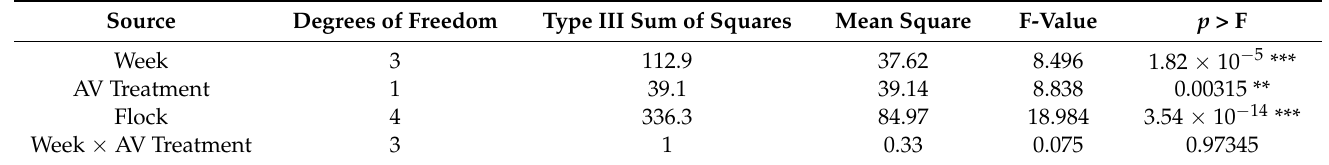
Table 9. Results of analysis of covariance test for testing age effect on broiler surface temperature.